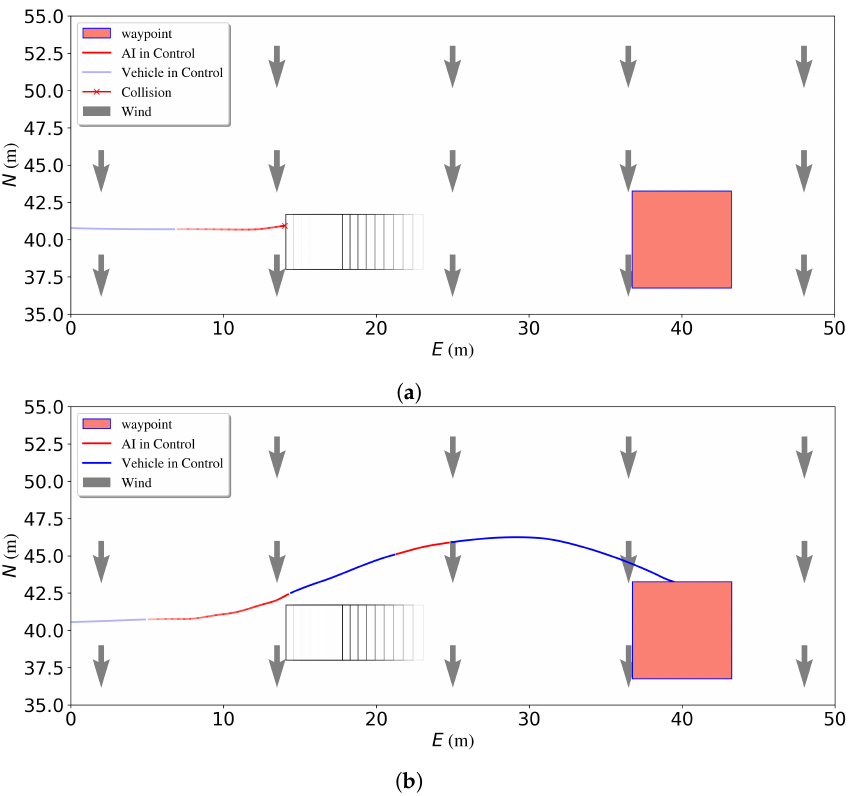
Figure 13. Performance of different waypoint trackers when a USV avoids an obstacle in head- on scenario in simulation. ( a ) Collision happens without using NN-MPC. ( b ) Collision avoidance using